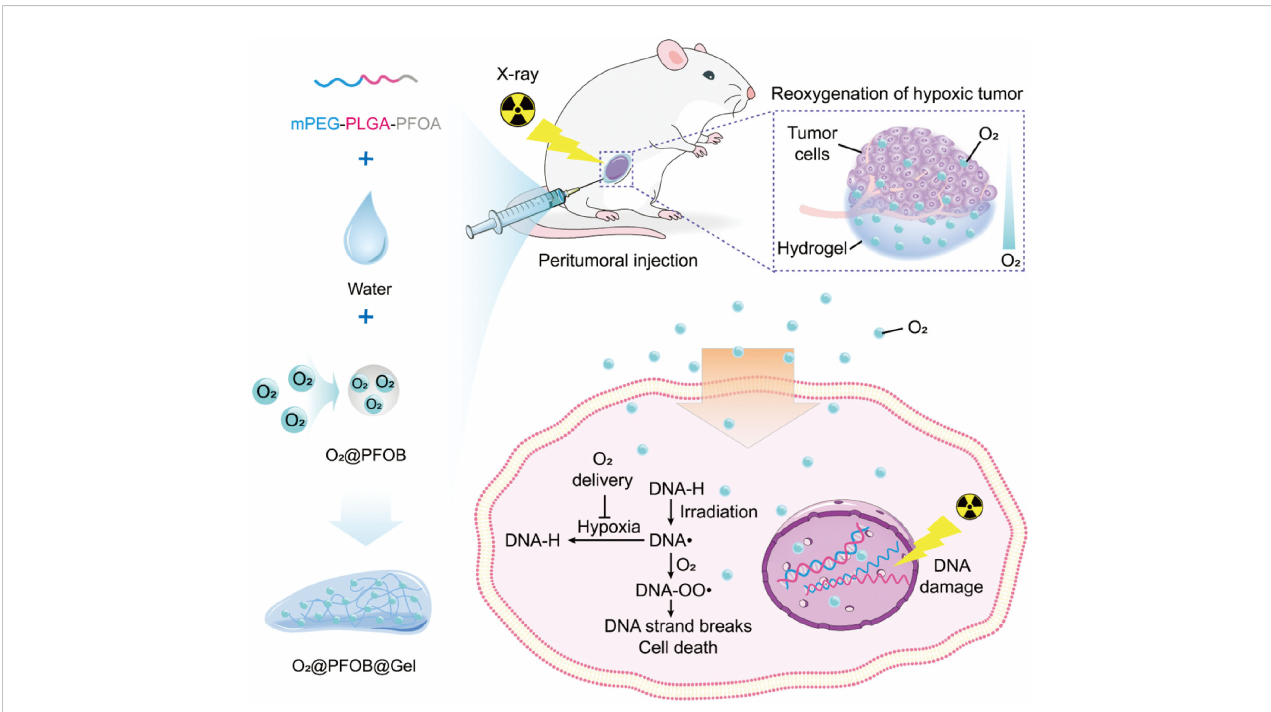
FIGURE 5 Schematic representation of the preparation of an oxygen-enriched thermosensitive composite hydrogel (O 2 @PFOB@Gel) and its radiosensitizing effect on tumor. The thermosensitive composite hydrogel undergoing a thermoreversible sol – gel transition is made up of a PFOA-modi fi ed mPEG – PLGA diblock copolymer and PFOB. After peritumoral injection of the O 2 @PFOB@Gel system, the hypoxic tumor microenvironment gains great alleviation via the sustained release of oxygen. As the released oxygen reacts with a damaged segment of DNA strand that is induced by X-ray exposure, the repair of DNA strand breaks is inhibited, resulting in more cell death. Consequently, a radiosensitizing effect is achieved